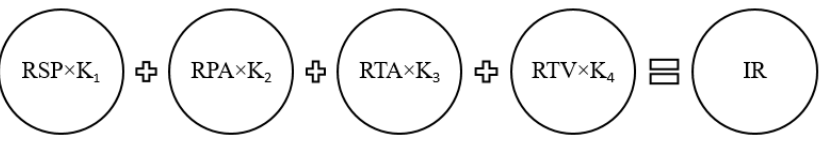
Figure 3. Method of calculation of integrated risk factor influence.